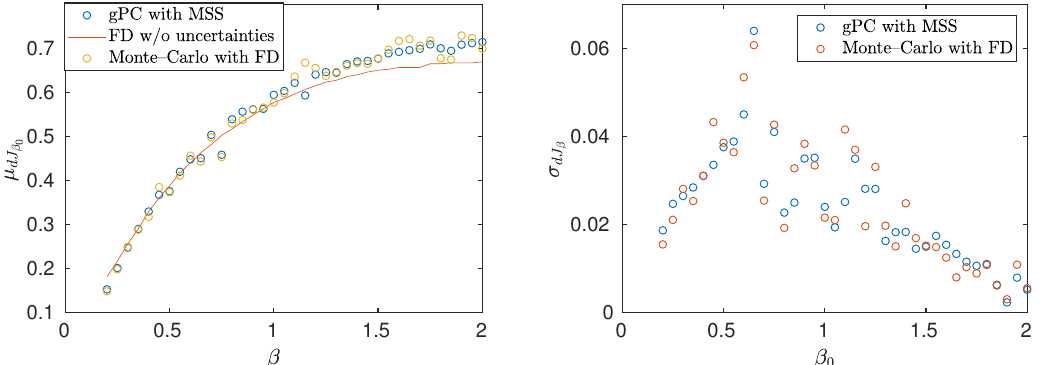
Figure 12. Comparison of mean value ( left ) and standard deviation ( right ) of the sensitivity of (35), as computed by the gPC coupled with MSS and the Monte–Carlo for N = 7500 samples. In both cases, T = 100. The chaos order is c =